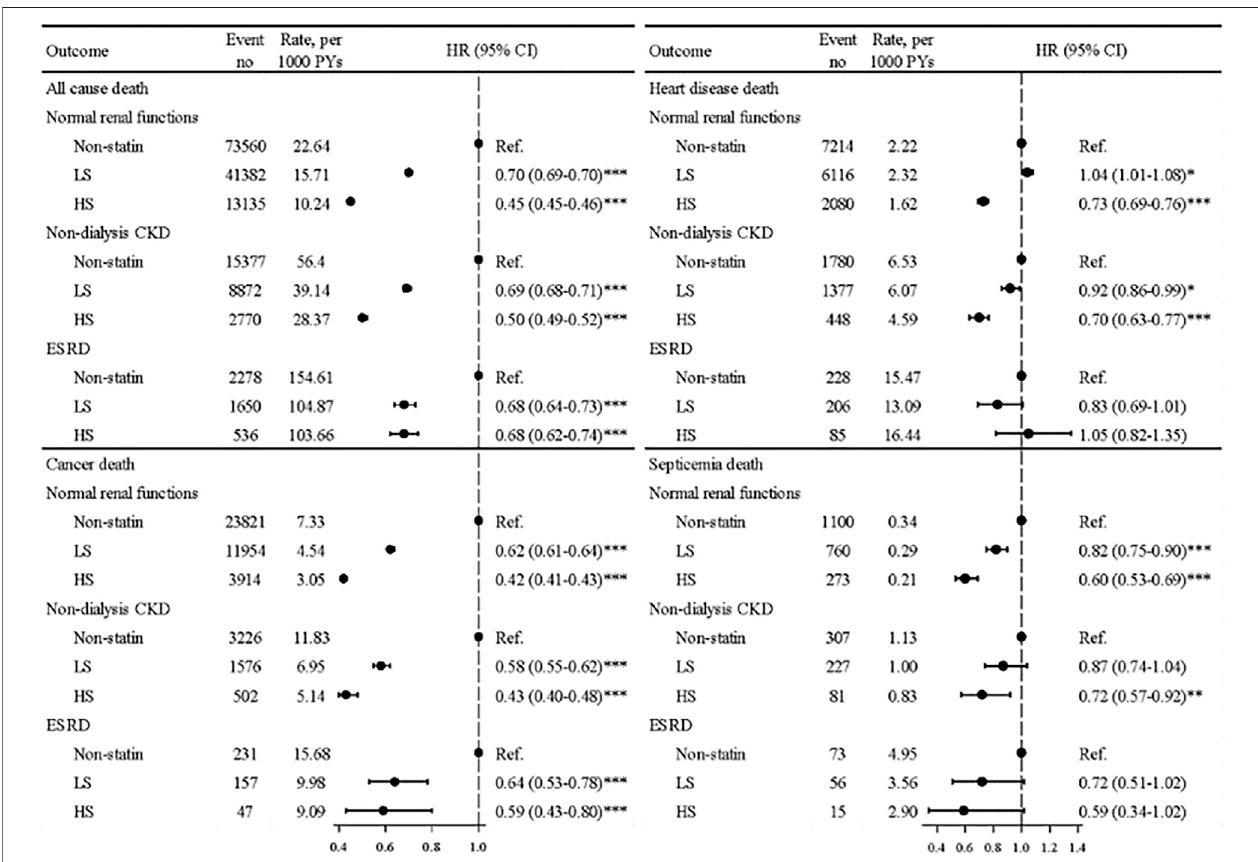
FIGURE. 3 | Mortality rates from all causes, cancer, heart disease, and septicemia and aHRs in patients using hydrophilic statins, lipophilic statins, and nonusers among three renal groups.